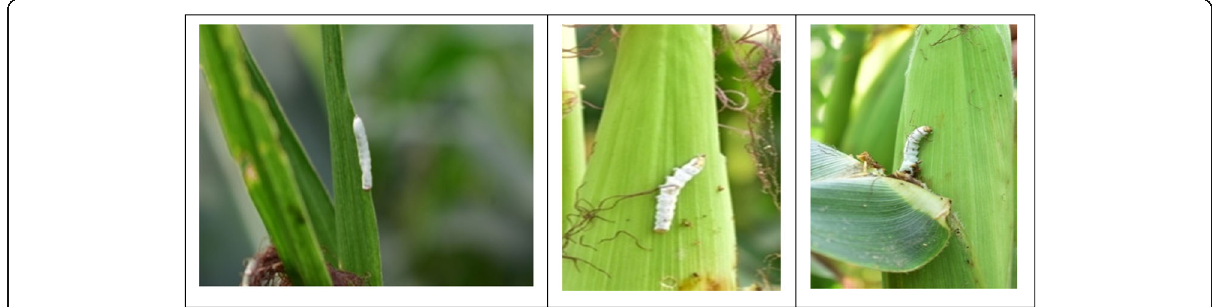
Fig. 1 Metarhizium rileyi natural infection on fall armyworm, Spodoptera frugiperda larvae on Maize leaf, leaf sheath, silk, and cob